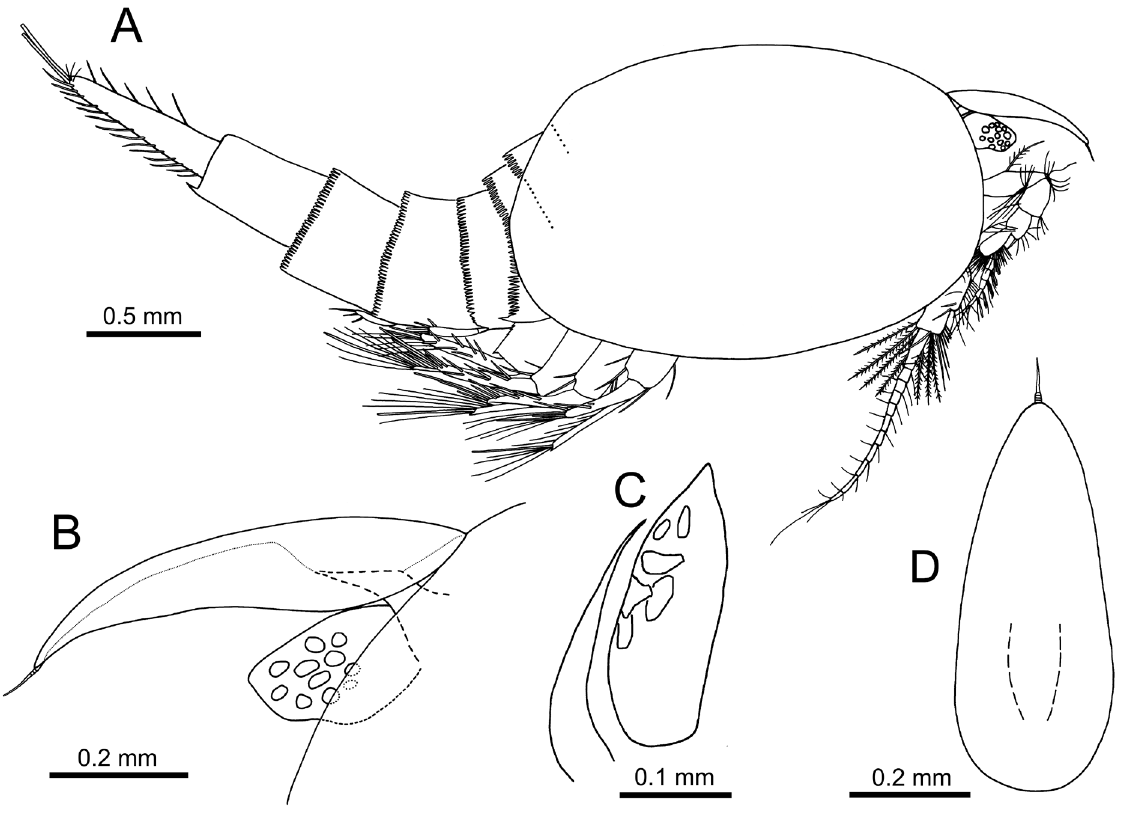
B–D . Paratypes (MNCN 20.04/13708, MNCN 20.04/13709). A . Complete specimen, lateral view. B . Rostrum and eye, lateral view. C . Eye and supra-orbital plate, ventral view. D . Rostrum, dorsal view. A: dashed lines marking distribution of denticles on posterior borders of pleonites II and